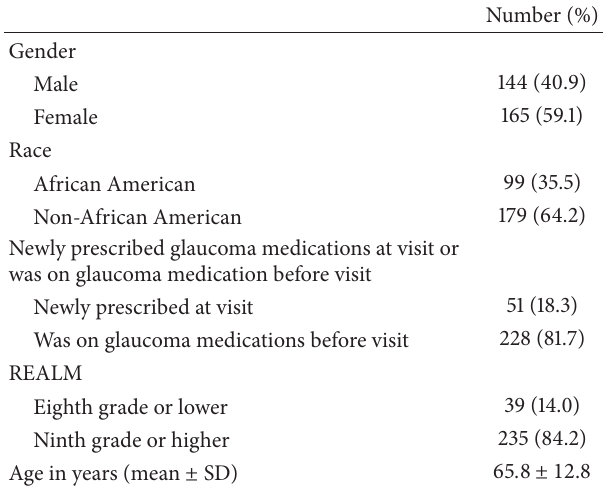
Table 1: Subject characteristics ( 𝑁 = 279